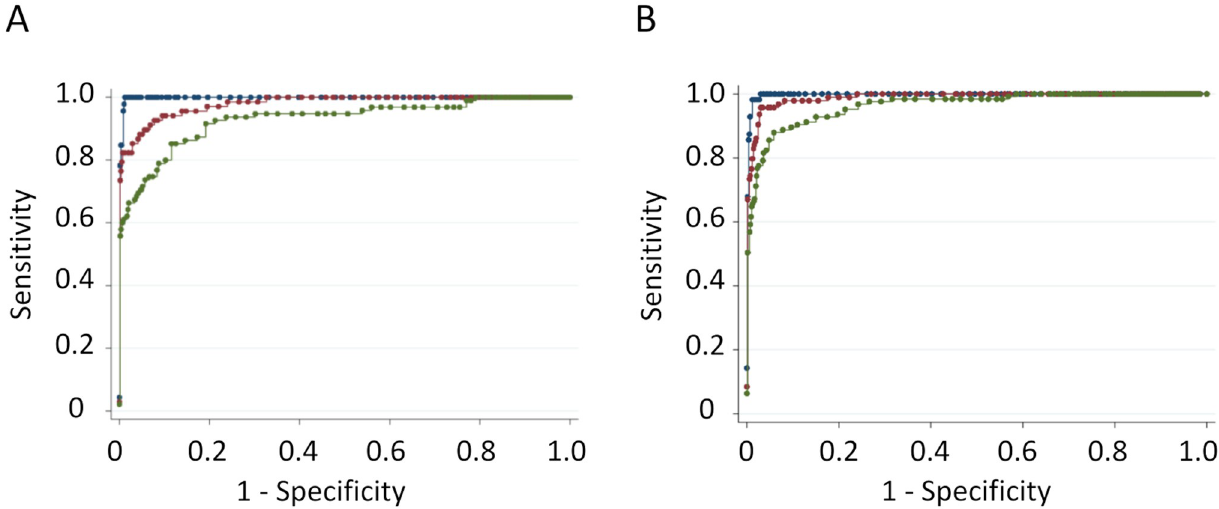
Fig 5. Receiver operating characteristics for the STANDARD G6PD Test against the reference assays for G6PD in capillary specimens. Discrimination of G6PD deficient males and females ( � 30% G6PD activity) from females with intermediate activity and males and females with normal activity (dark blue); discrimination of females with intermediate activity ( > 30% and � 70% G6PD activity) from females with normal G6PD activity (red); and discrimination of females with intermediate activity ( > 30% and � 80% G6PD activity) from females with normal G6PD activity. (green), for (A) capillary specimens and (B) venous specimens.